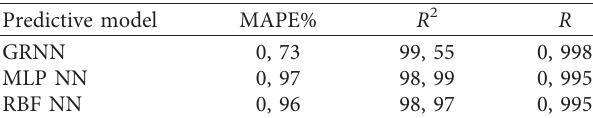
Table 4: Comparison of the accuracy among GRNN, MLP NN, and RBF NN (results for validation